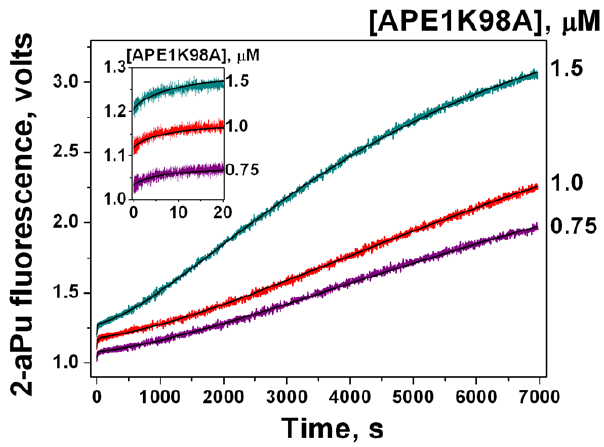
Figure 7. 2-aPu fluorescence traces of the substrate (2- aPu)DHU/G (1 m M) upon interaction with APE1K98A. The reaction was carried out in NIR buffer. Smooth black curves are the result of the fitting procedure. Concentrations of the enzyme are indicated next to the right axis. The insert shows the initial region ( , 20 s) of the fluorescence intensity increase, reaching an intermediate plateau. This region corresponds to phase 1. Phase 2 is a subsequent increase in the fluorescence intensity up to , 4000 s. The increase in the fluorescence intensity at . 4000 s corresponds to the beginning of phase 3.